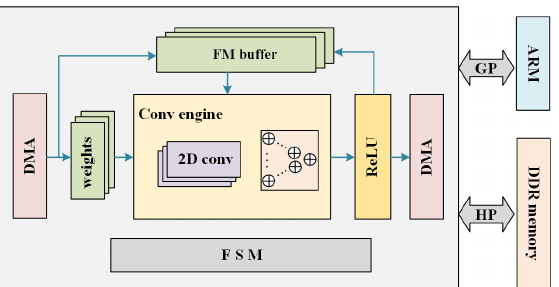
Figure 7. Hardware architecture of the CNN accelerator on the